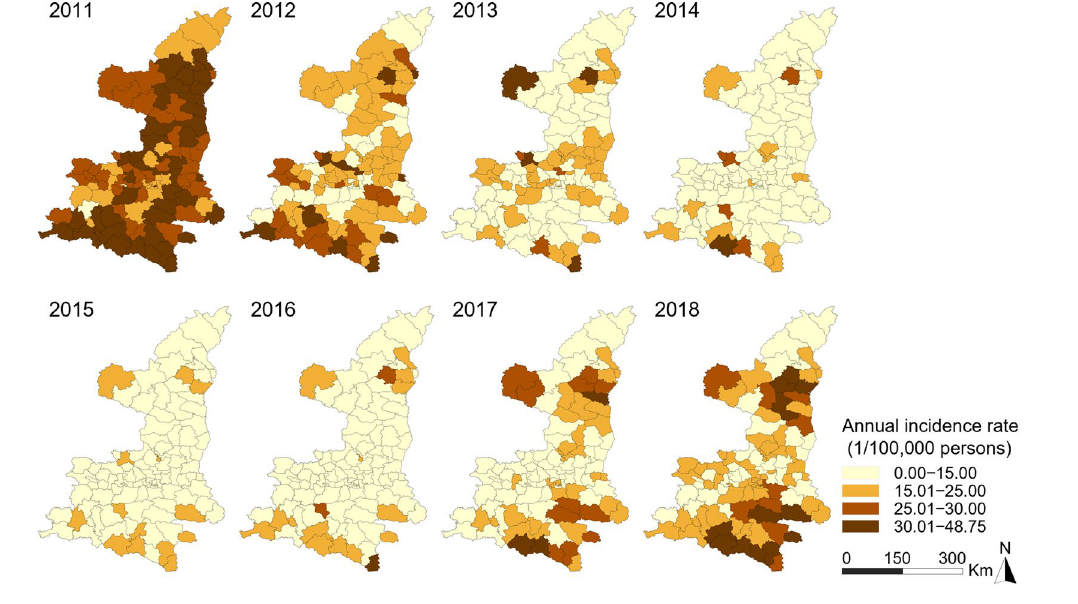
Figure 3. Annual notified incidence rate of BP-PTB.